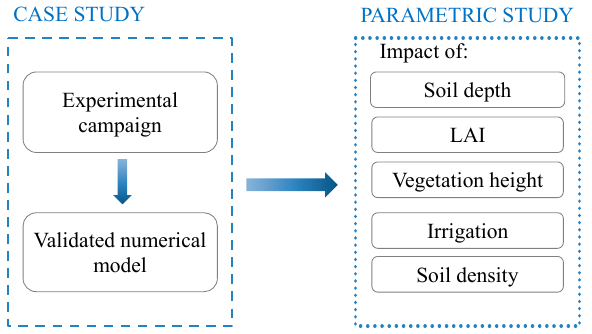
Figure 1. Methodology flowchart. LAI—leaf area index.